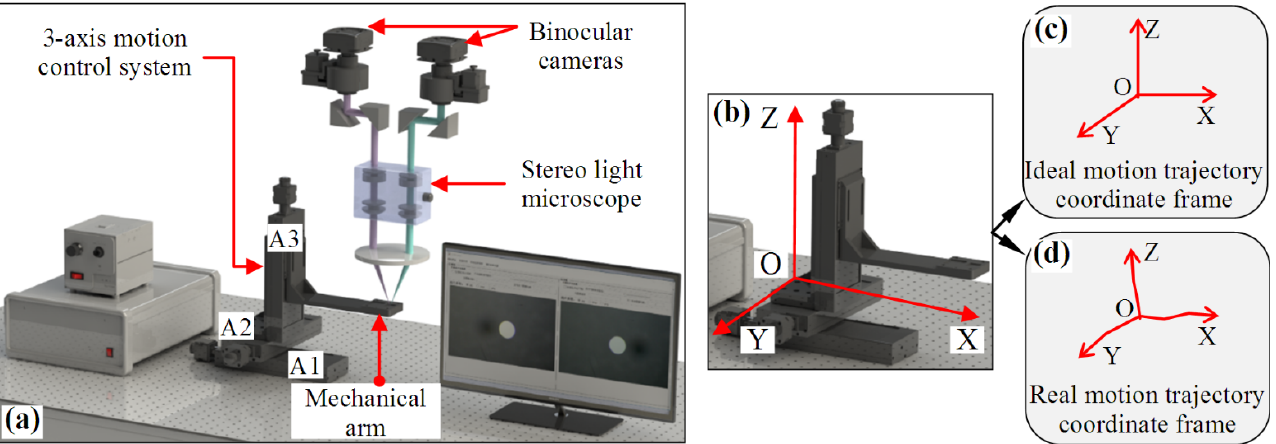
Figure 1. The setup of one kind of micro-manipulation system using a 3-axis motion control system. ( a ) General composition of the system, A1: X-axis linear motion module, A2: Y-axis linear motion module, A3: Z-axis linear motion module. ( b ) Definition of the motion trajectory coordinate frame. ( c ) For an ideal motion trajectory coordinate frame, when moving along its three motion axes (X-axis, Y-axis and Z-axis), the trajectories should be straight and orthogonal. ( d ) For a real motion trajectory coordinate frame, when moving along its three motion axes, the trajectories may be curves with slight deformation, and the perpendicularity of the fitting trajectory lines may deviate by 90 degrees.